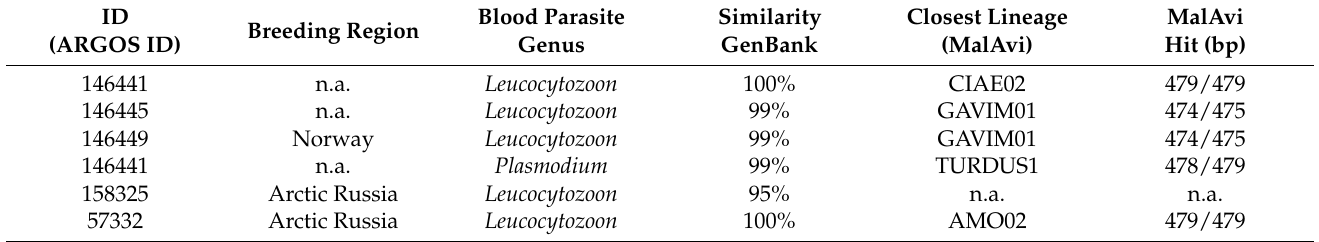
Table A3. List of positively tested red-throated divers for blood parasite infections, with ID (ARGOS- ID), parasite genera and identity match. Sample ID 158325 is only available with the forward sequence and therefore MalAvi hit and lineage information is not